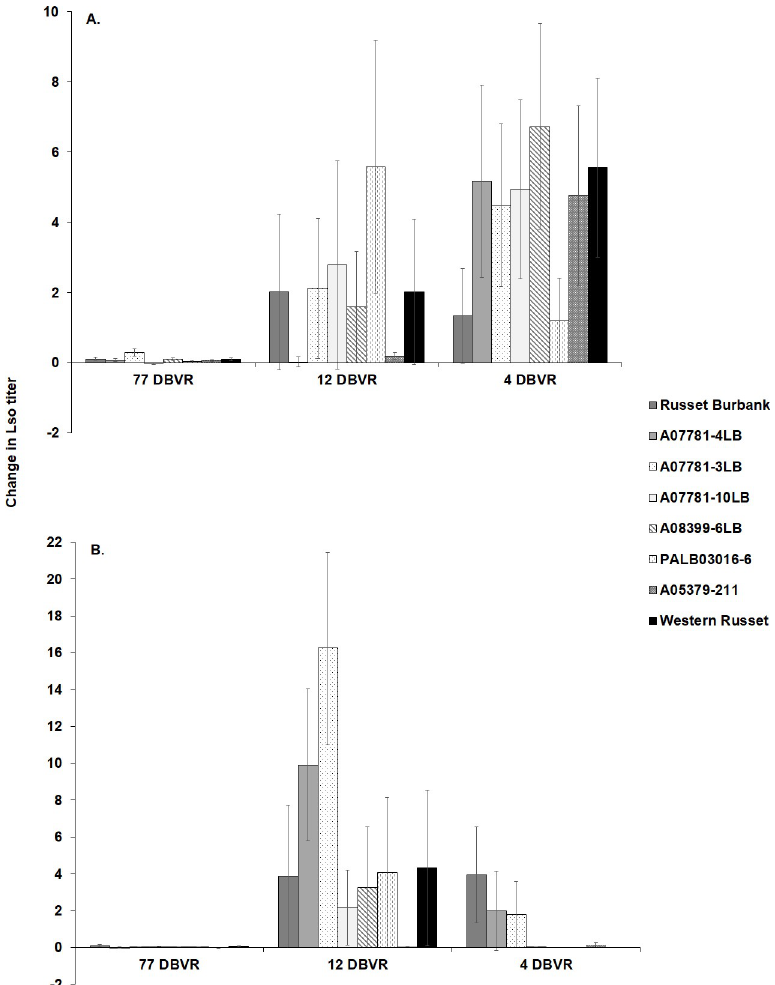
Fig 5. Changes in Lso titer in tubers of potato genotypes between harvest and storage. Tubers from (A) 2016 and (B) 2017 were infested at either 77, 12 or 4 DBVR and were evaluated for their Lso titer at harvest and after cold storage. Although, no significant differences were detected in time of infestation-genotype interaction in both 2016 and 2017, the Lso change in A07781-3LB tended to be higher than the susceptible control, Russet Burbank in 2017. Bars represent estimated values of Lso change. The change in Lso titer was estimated from log-transformed Lso copy numbers. Error bars represent standard error ( ± 1).